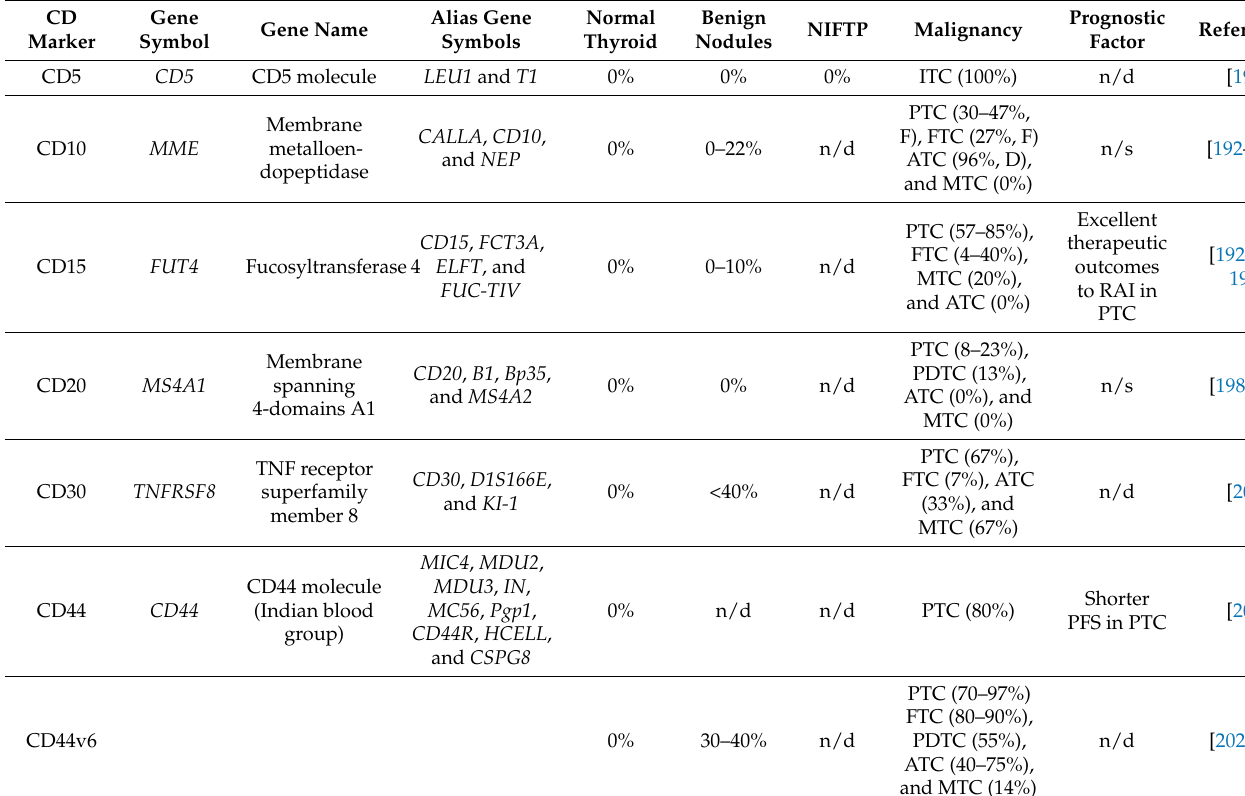
Table 4. CD marker expression in thyroid